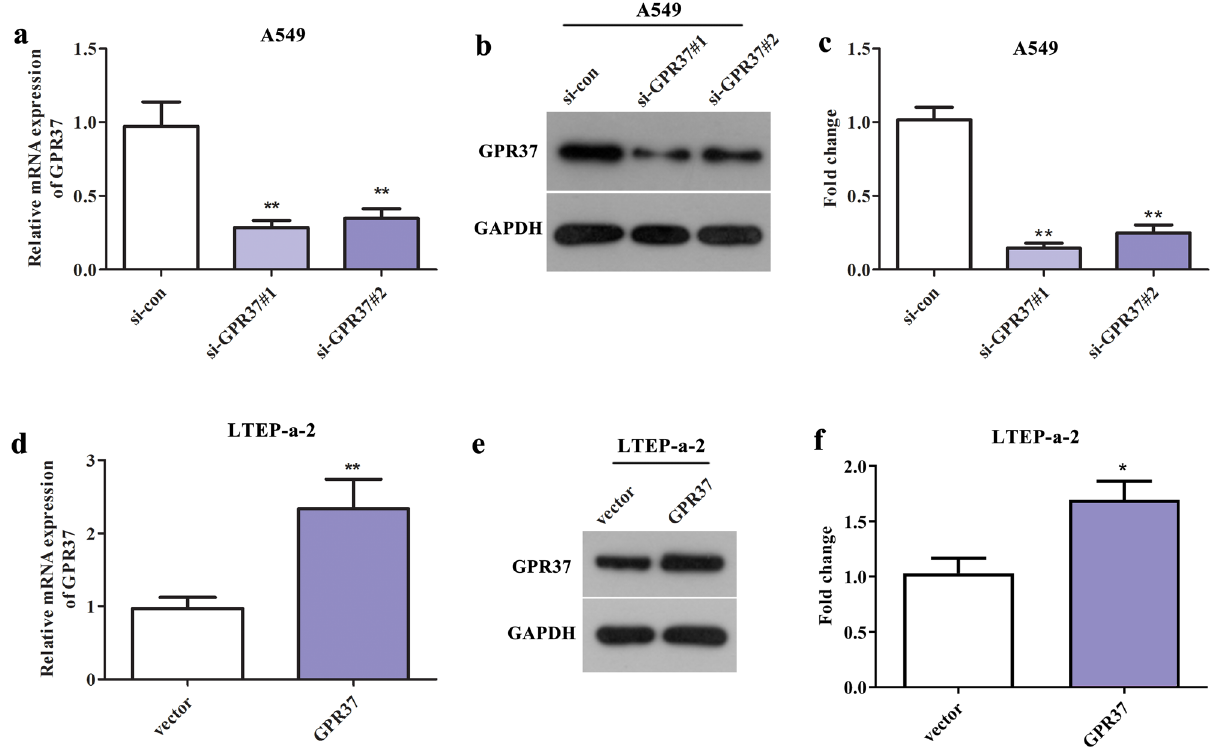
Figure 2: The transfection e ffi ciency of GPR37 downregulation/upregulation in LUAD cell lines A549 and LTEP - a - 2. qRT - PCR and western blot assays were performed to measure the ( a ) mRNA and ( b and c ) protein levels of GPR37 in A549 cells after transfected with si - GPR37#1 and si - GPR37#2. ** P < 0.01 vs si - con group. Concurrently, the ( d ) mRNA and ( e and f ) protein levels of GPR37 in LTEP - a - 2 cells after transfected with pcDNA3.1 - GPR37 were also detected using qRT - PCR and western blot assay. ** P < 0.01 vs vector group. * P < 0.05 vs vector